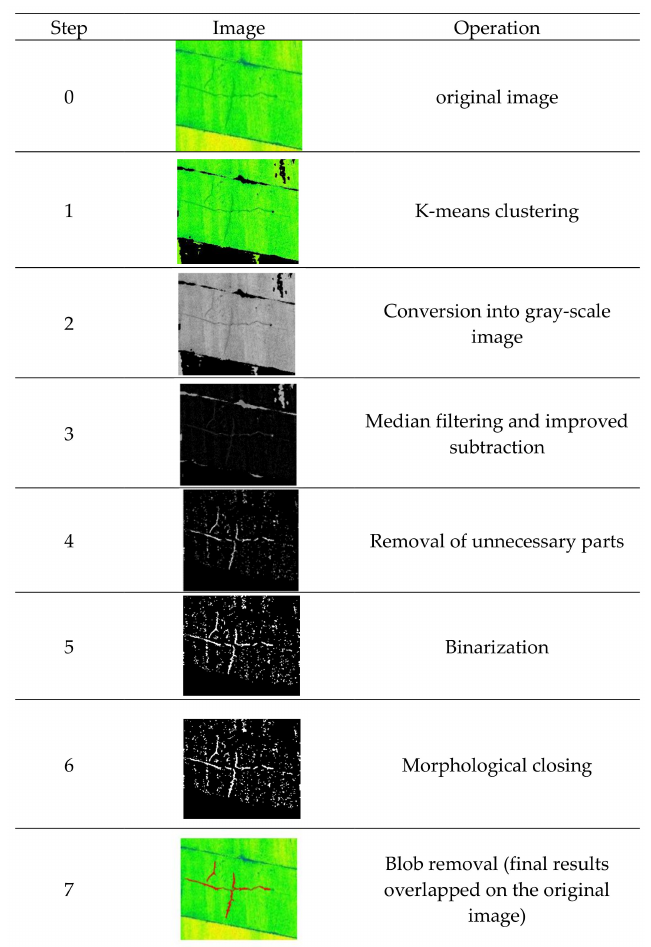
Figure 7. Example of the proposed image